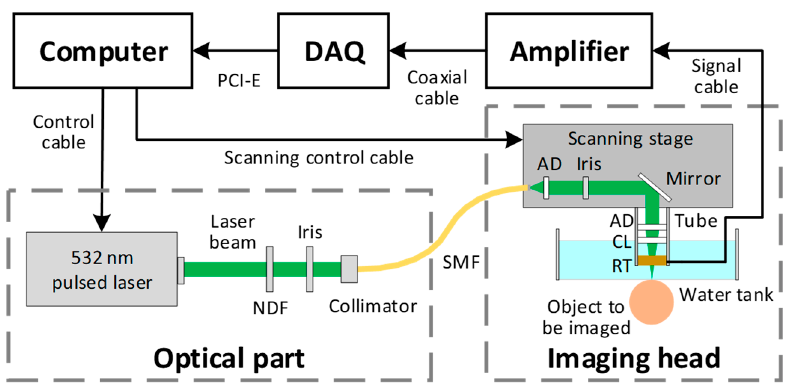
Figure 1. Schematic of the photoacoustic microscopy (PAM) system.